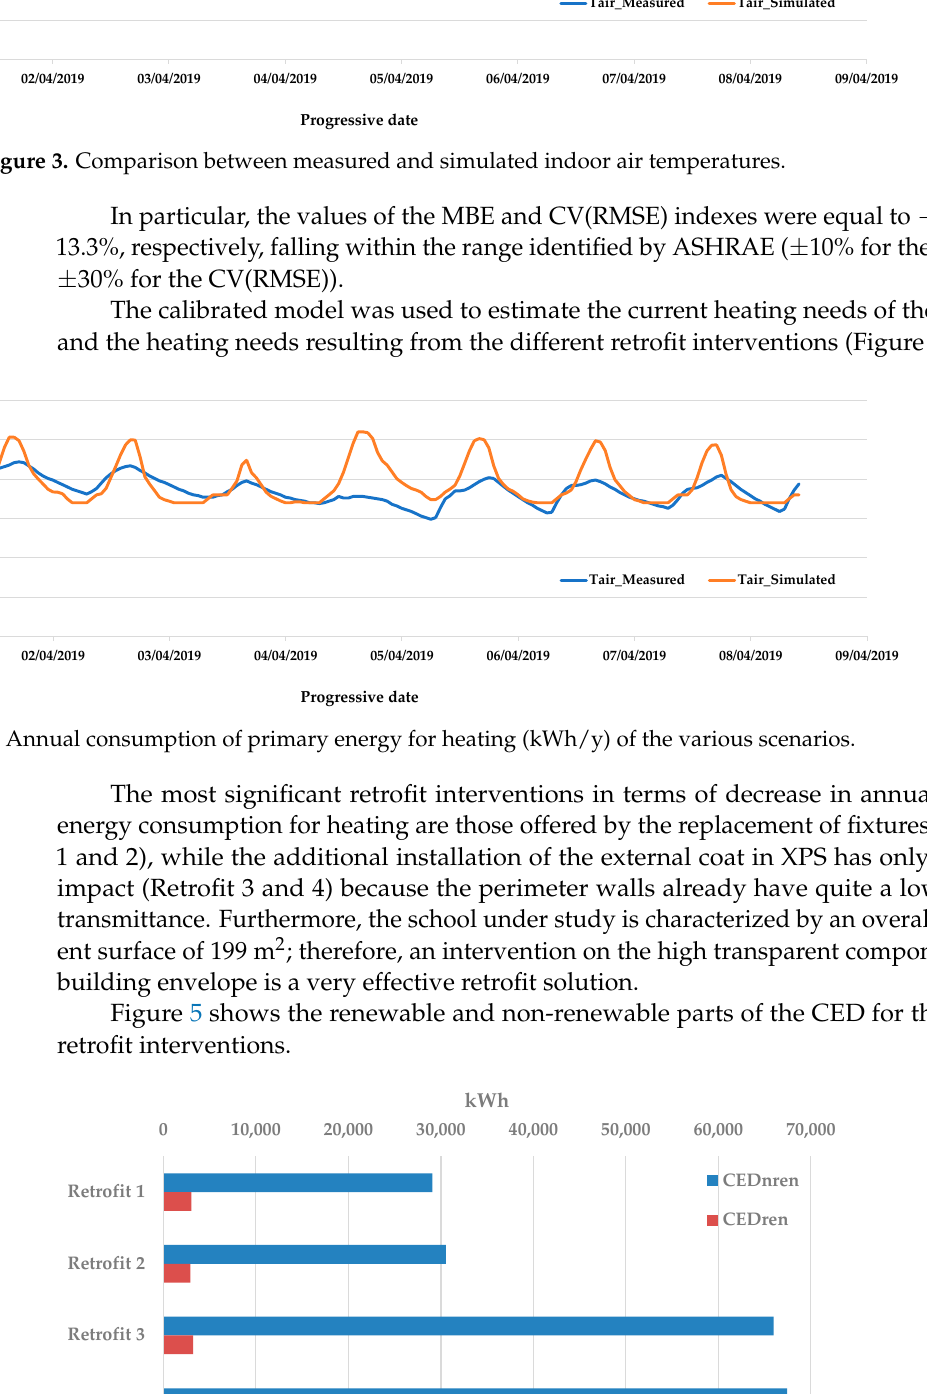
Table 2. Results related to energy and CO 2 paybacks. Retrofit Option